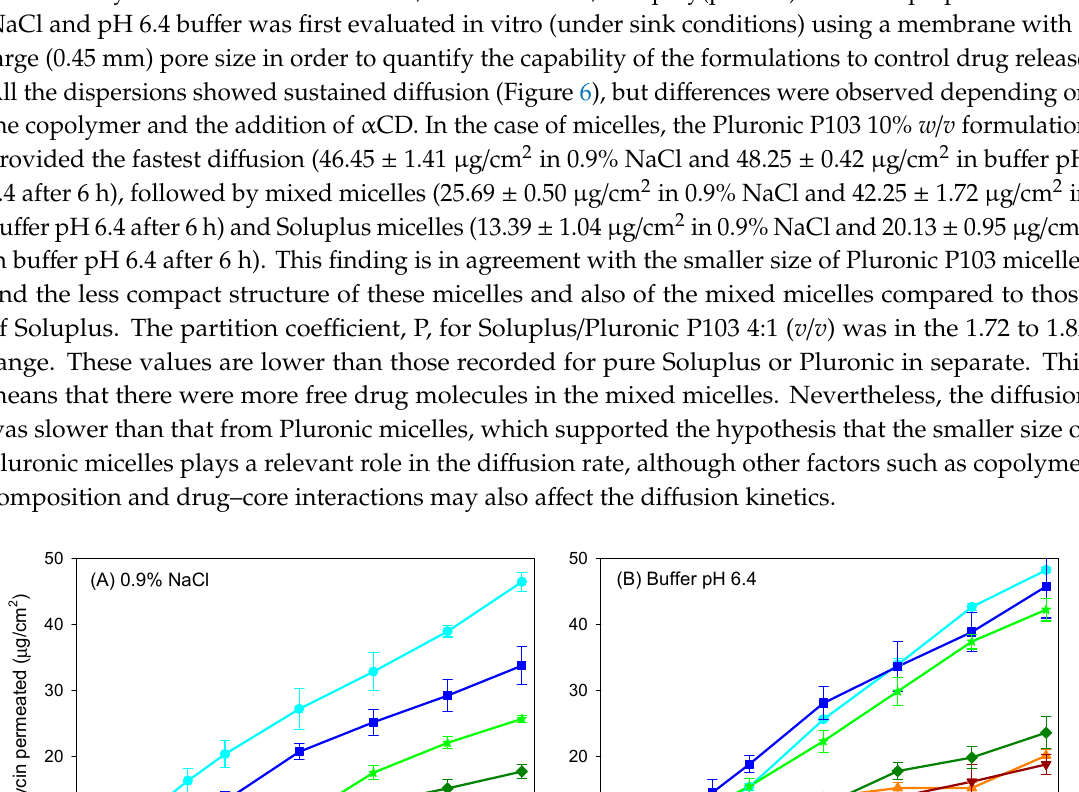
Table 4. Natamycin diffusion coefficients from Soluplus and Pluronic micelles, Soluplus:Pluronic P103 4:1 v/v mixed micelles, and poly(pseudo)rotaxanes in 0.9% NaCl and pH 6.4 buffer. Total copolymer concentration was 10% w / v . Mean values and, in parenthesis, standard deviation (n = 3). Formulation